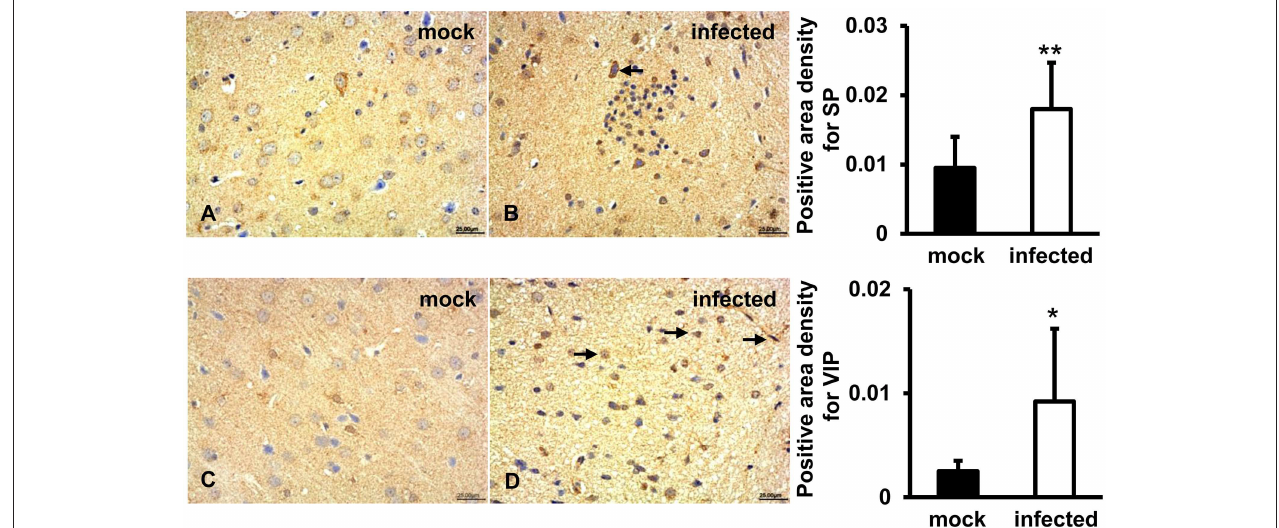
FIGURE 5 | Immunoregulation of the brain tissue during HEV infection. HEV-RNA positive brain tissues collected on 14, 21, and 28 dpi were used for immunohistochemistry study of SP (rabbit polyclonal IgG) and VIP (rabbit polyclonal IgG). Goat anti-rabbit IgG was chosen as secondary antibody. The positive signal was measured via the Motic Med 6.0 CMIAS Image Analysis System. (A,B) A positive signal of SP was found in the cytoplasm of neuronal cells of brain tissue in both groups and was significantly induced in HEV infected animals compared with animals from mock group (** p < 0.01). (C,D) Expression of VIP was observed in vascular endothelial cells, astrocytes and oligodendrocytes in both groups, with significantly increased levels in HEV infected tissues compared with tissues from mock group (* p <